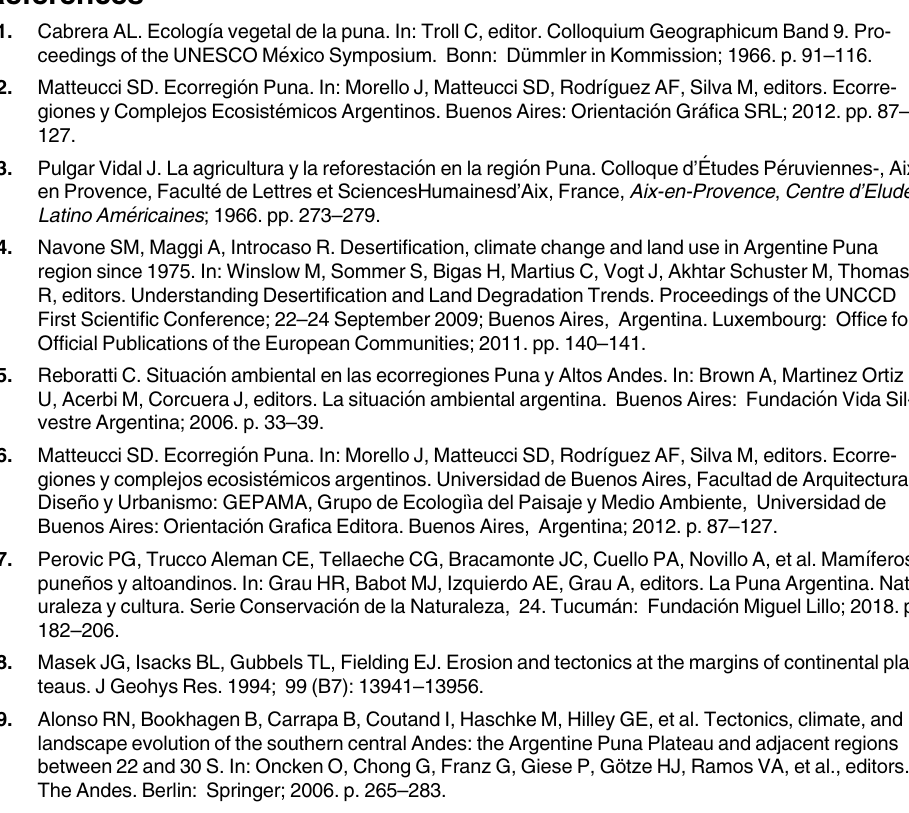
S3 Table. Comparative sampling-count chart among Grupo Salta Basin sedimentary units.